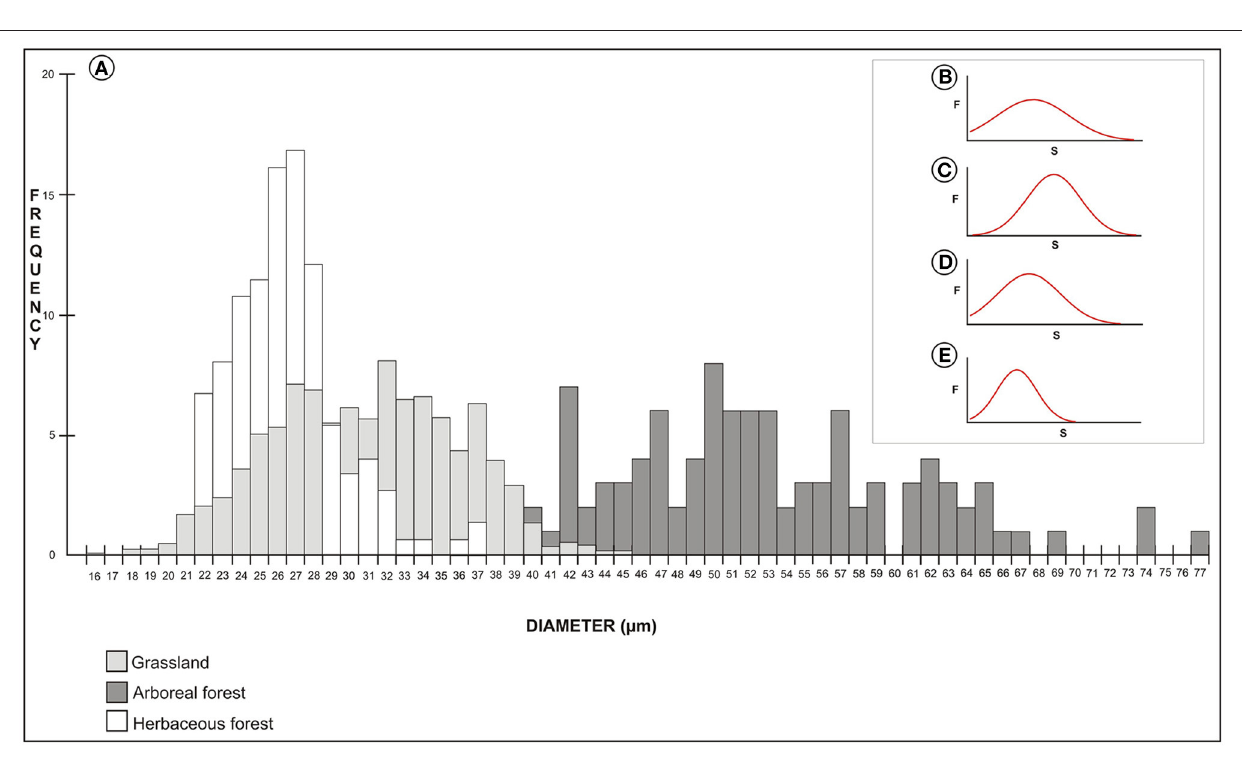
species ranged from medium to large, while that of